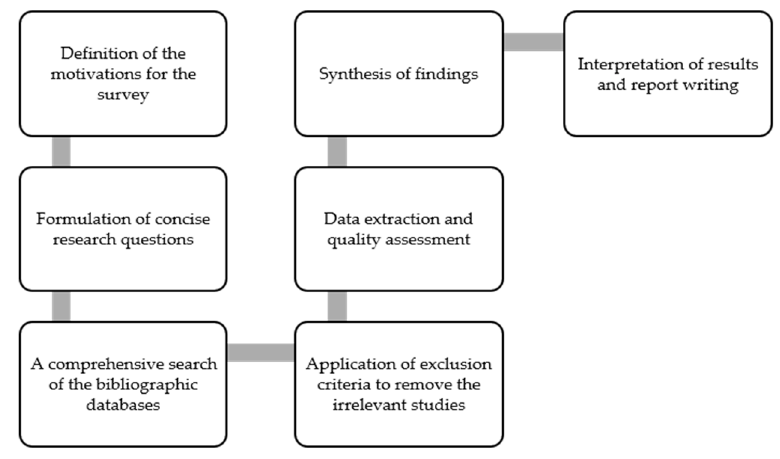
Figure 1. Major steps of our survey methodology.